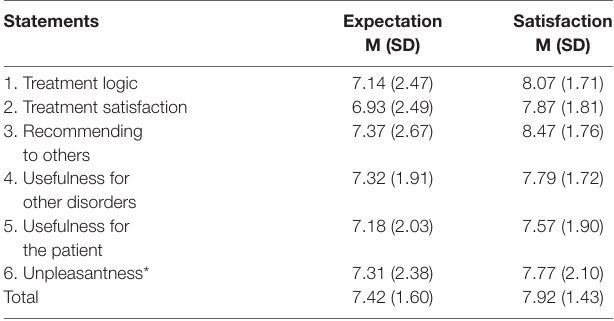
TABLE 3 | Means and standard deviations for expectation and satisfaction